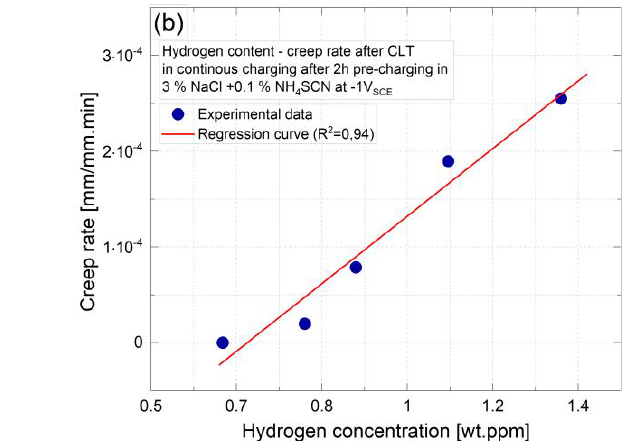
Figure 7. CLT-based results with applied load as a function of time to fracture. The CLT of hydrogen charged specimens are performed at continuous hydrogen charging, after 2 h of pre-charging under conditions corresponding to the critical hydrogen concentrations.